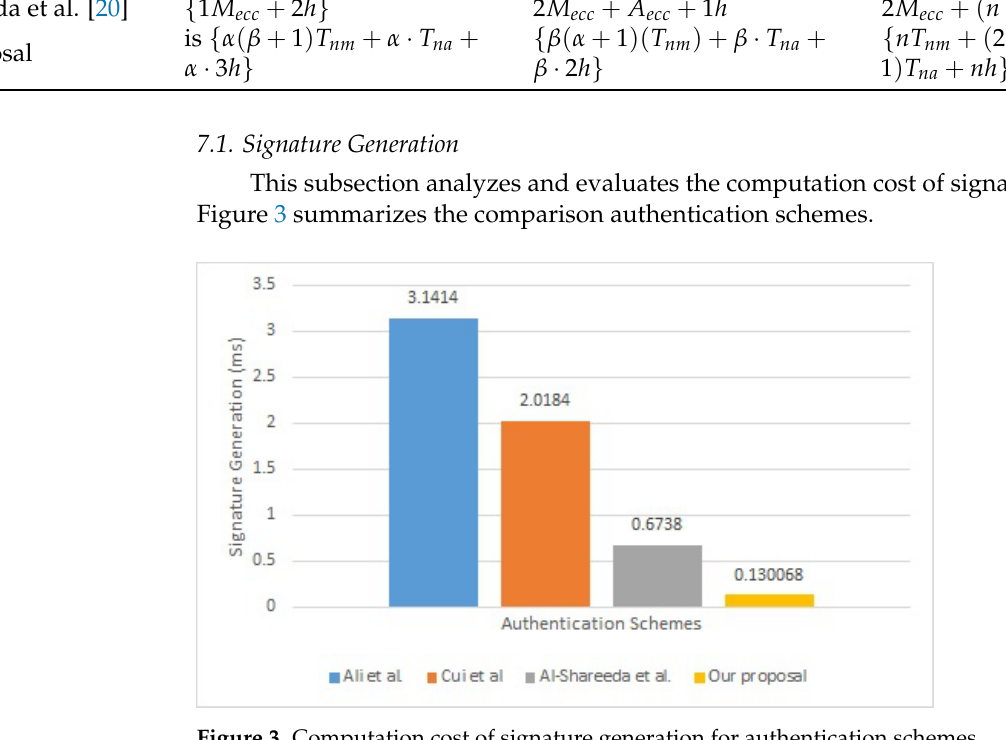
Figure 3. Computation cost of signature generation for authentication